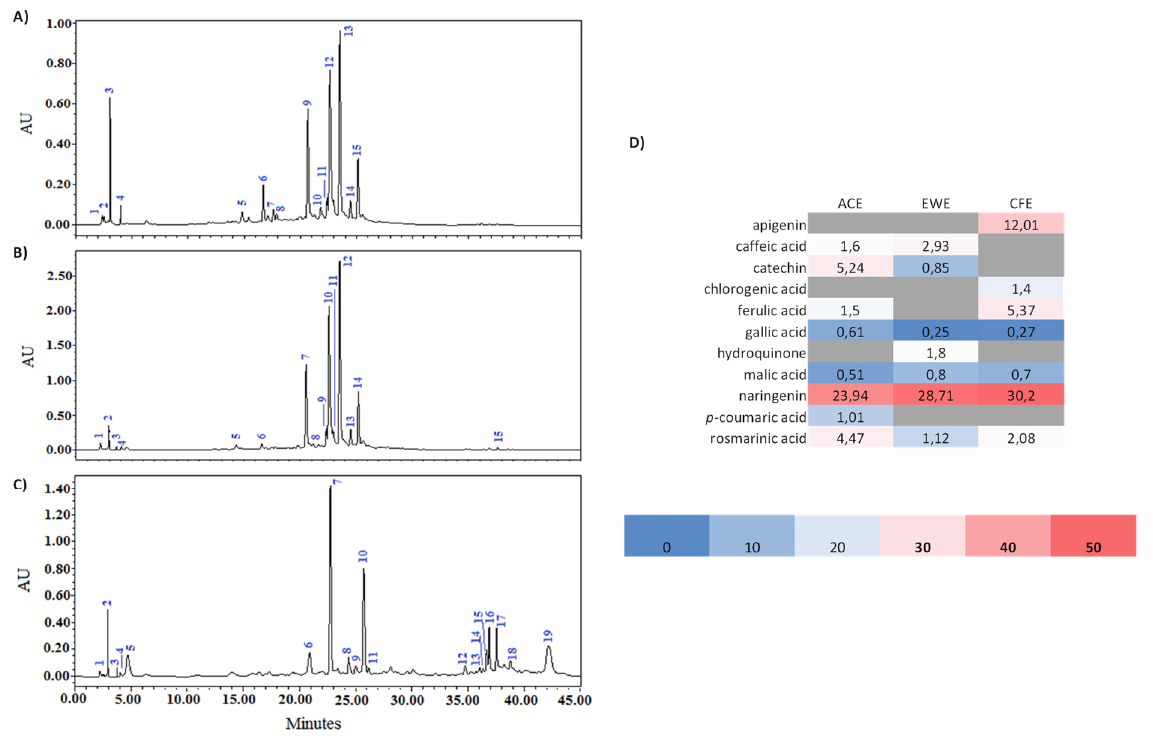
Figure 4. HPLC chromatogram patterns of extracts from C. aurantium L. peel: ( A ) acetone ((2) malic acid (0.51%), (3) rosmarinic acid (4.47%), (4) gallic acid (0.61%), (5) caffeic acid (1.60%), (6) catechin (5.24%), (8) p-coumaric acid (1.01%), (10) ferulic acid (1.50%), (12) naringenin (23.94%)); ( B ) ethanol–water ((1) malic acid (0.80%), (2) rosmarinic acid (1.12%), (3) gallic acid (0.25%), (4) hydroquinone (1.80%), (5) caffeic acid (2.93%), (6) catechin (0.85%), (10) naringenin (28.71%)); ( C ) chloroform ((1) malic acid (0.70%), (2) rosmarinic acid (2.08%), (3) gallic acid (0.27%), (6) ferulic acid (5.37%), (7) narin- genin (30.20%), (9) chlorogenic acid (1.40%), (19) apigenin (12.01%)); and ( D ) relative quantification (%) of individual compounds identified in each